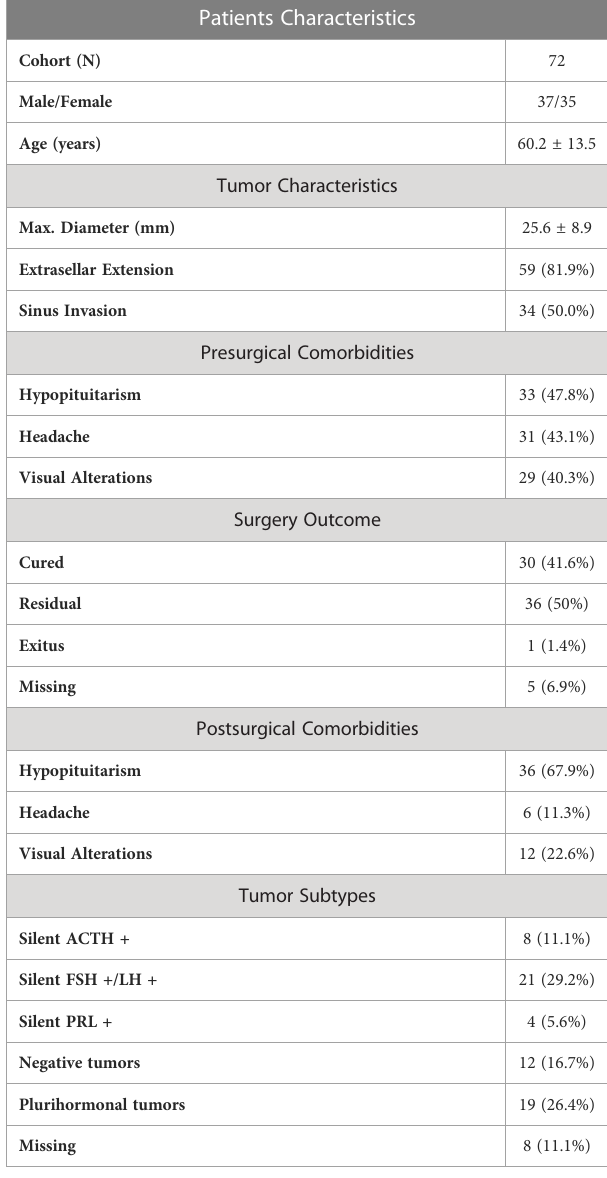
TABLE 1 Description of the